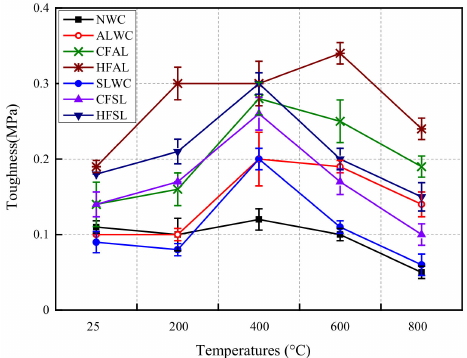
Figure 12. Effect of temperatures on the toughness of different concretes.